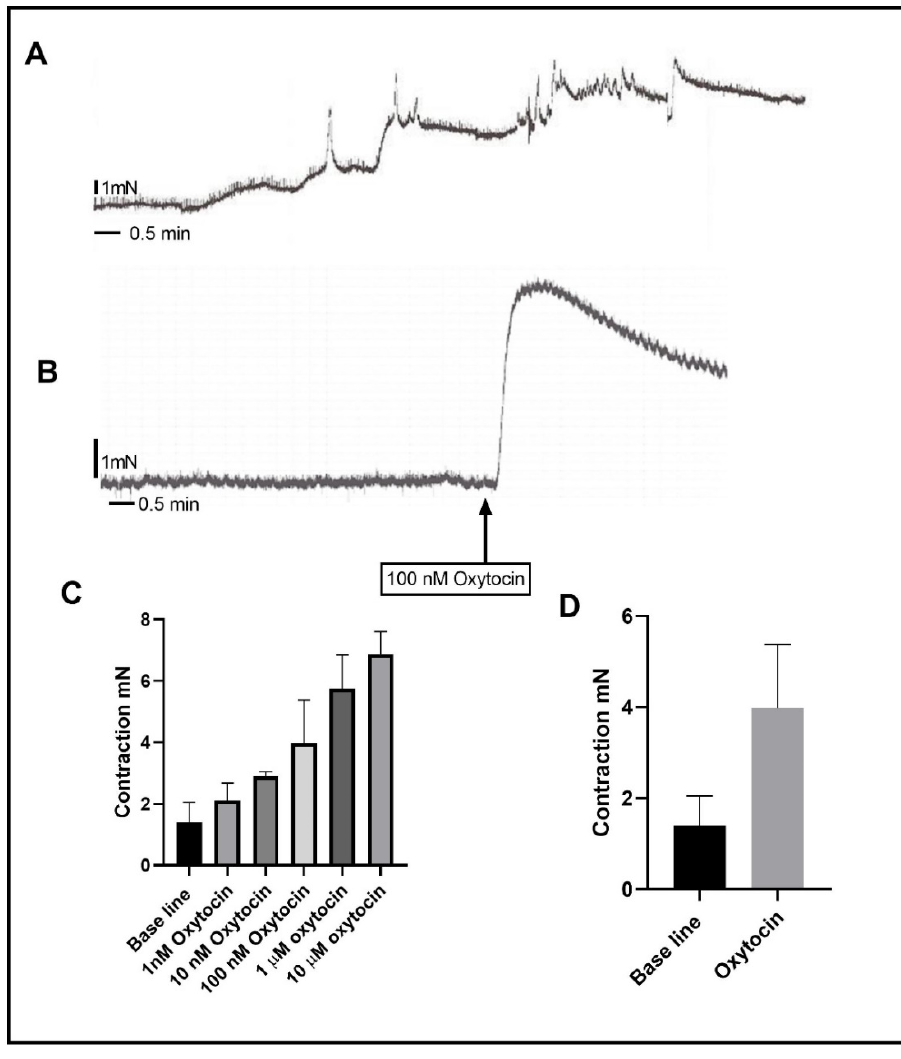
Figure 1. Effect of oxytocin on rat circular muscle strips from the gastric antrum. ( A ) is a summary of the effect of oxytocin on gastric smooth muscle strip. Oxytocin dose-dependently produced contraction in the range of 10 − 9 to 10 − 5 M. ( B ) is a representative trace illustrating that 100 nM oxytocin induced contraction in gastric circular muscle strips. ( C ) is a summary graph showing that oxytocin treatment dose-dependently significantly increased the contraction. ( D ) is a summary graph trace illustrating that 100 nM oxytocin induced contraction in gastric circular muscle strips. Data expression is in mN of force. Values are mean ± SEM. n = 11.